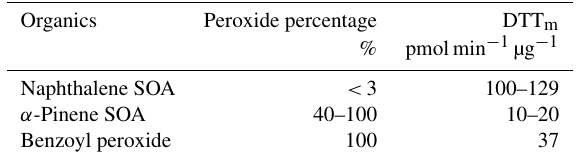
Table 2. SOA peroxide content and OP. Organics